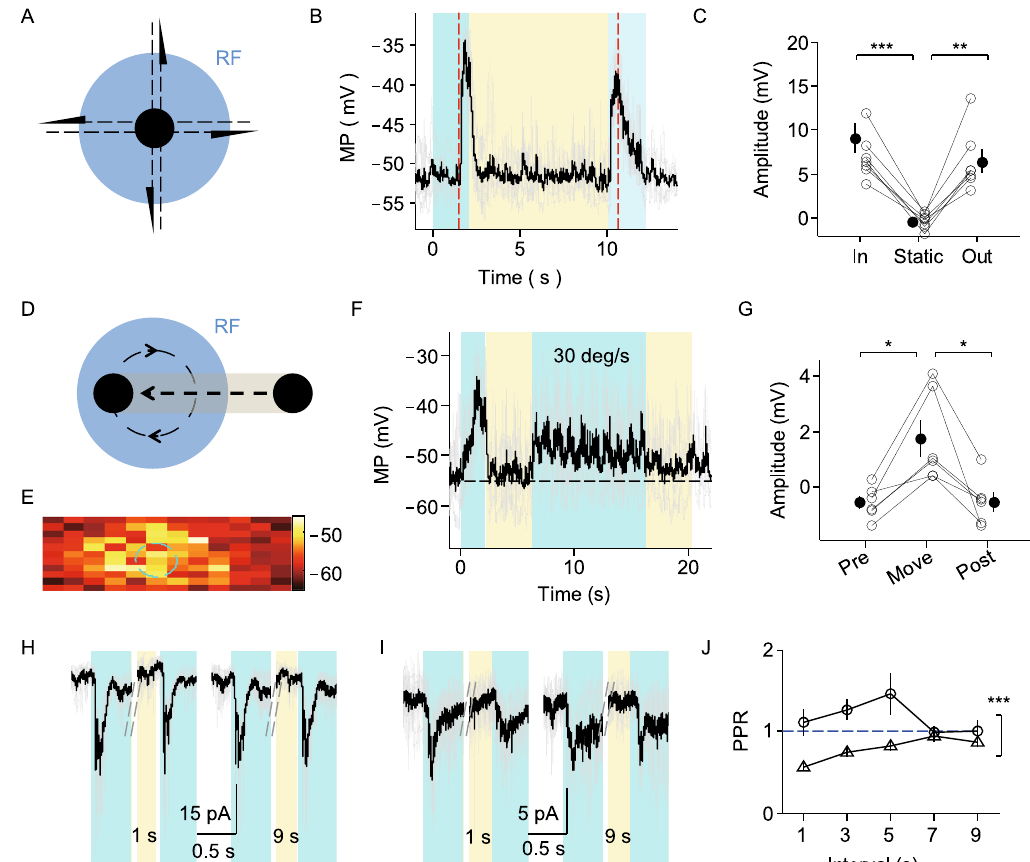
Figure 4. Motion response and visual adaptation of SINs. (A) Schematic showing moving dot stimulation. Dashed arrows indicate moving directions. (B and C) Voltage traces (B) and summary of data (C) ( n = 7; moving in versus static: P = 2.2 × 10 − 4 ; moving out versus static: P = 0.0018; both Student ’ s t -test) for responses to one dot in moving and static. Red dashed lines in (B) indicate dot moving into or out of the RF. Response peaks of moving in and out period were compared to averaged membrane potential from 1 s after static period onset and 1 s before static period offset, respectively (C). (D) Schematic showing moving dot stimulation. Dashed arrows indicate moving directions. (E) Heat map of the RF. Blue dashed line demarcating the rotating area. (F and G) Voltage traces (F) and summary of data (G) ( n = 6; moving versus pre-static: P = 0.0313; moving versus post-static: P = 0.0313; both Wilcoxon signed-rank test) for responses to dot in rotating in 30°/s and static. (H and I) Current traces for responses to paired visual stimuli for one representative SIN (H) and PVN (I), respectively. (J) Comparison of visual adaptation between SINs ( n = 8; circle) and PVNs ( n = 9; triangle) ( P = 1.6 × 10 − 4 , two-way